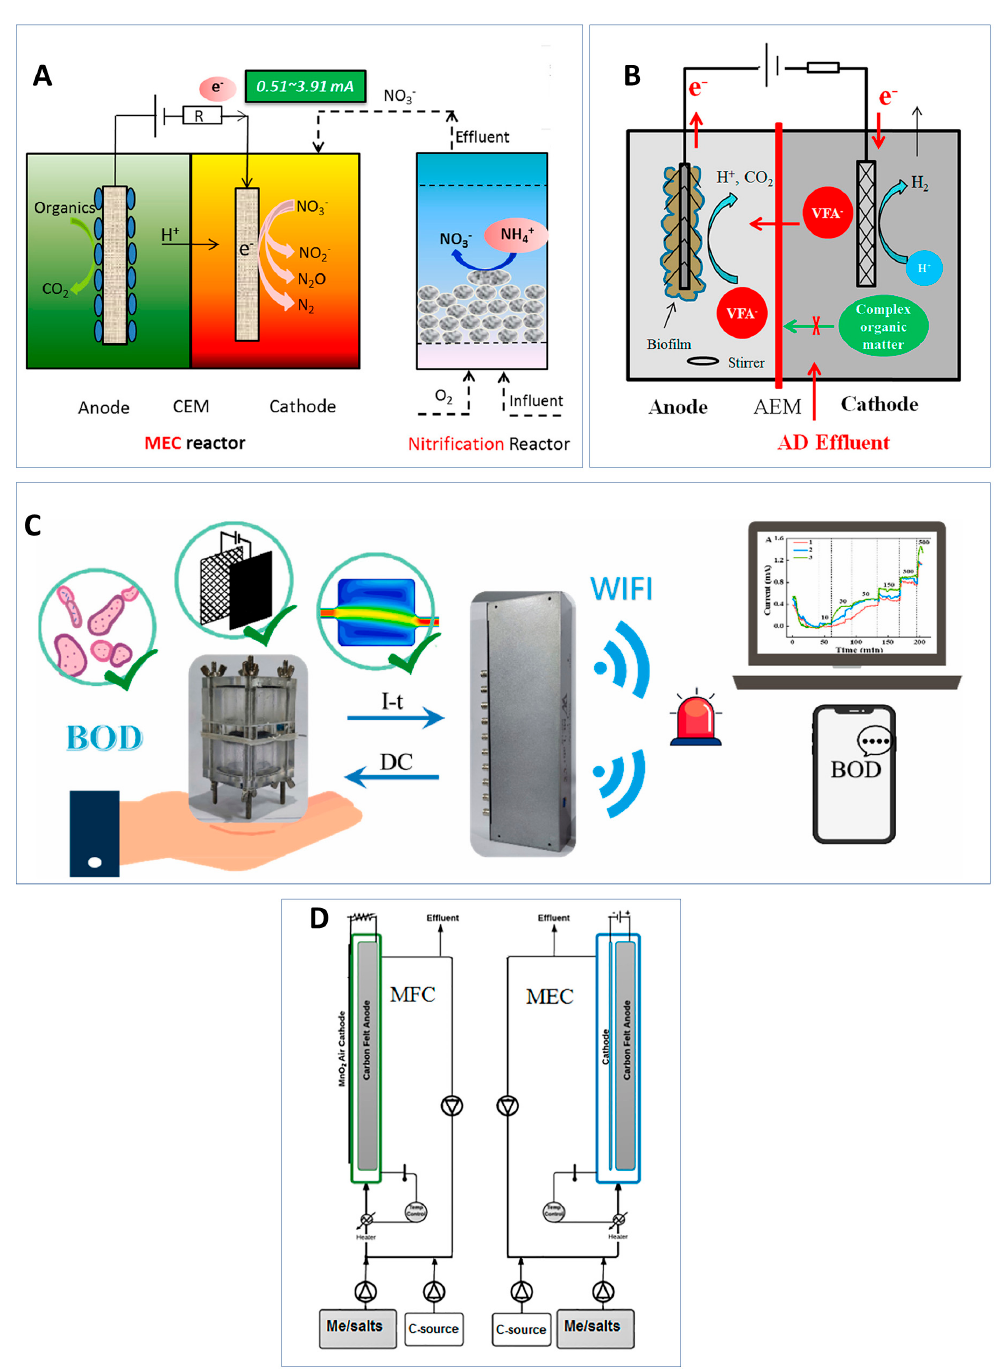
(Figure 5B) [169]. A linear correlation between the current density and VFA concentrations was observed under changing parameters, which demonstrates the potential use of MECs for VFA monitoring.